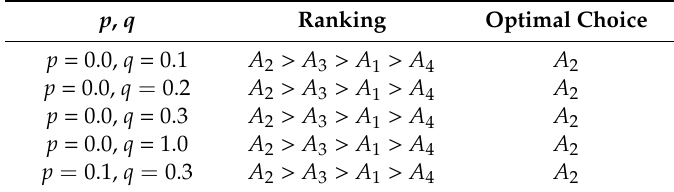
Table 4. The ranking of the alternative under di ff erent parameters p , q . p , q